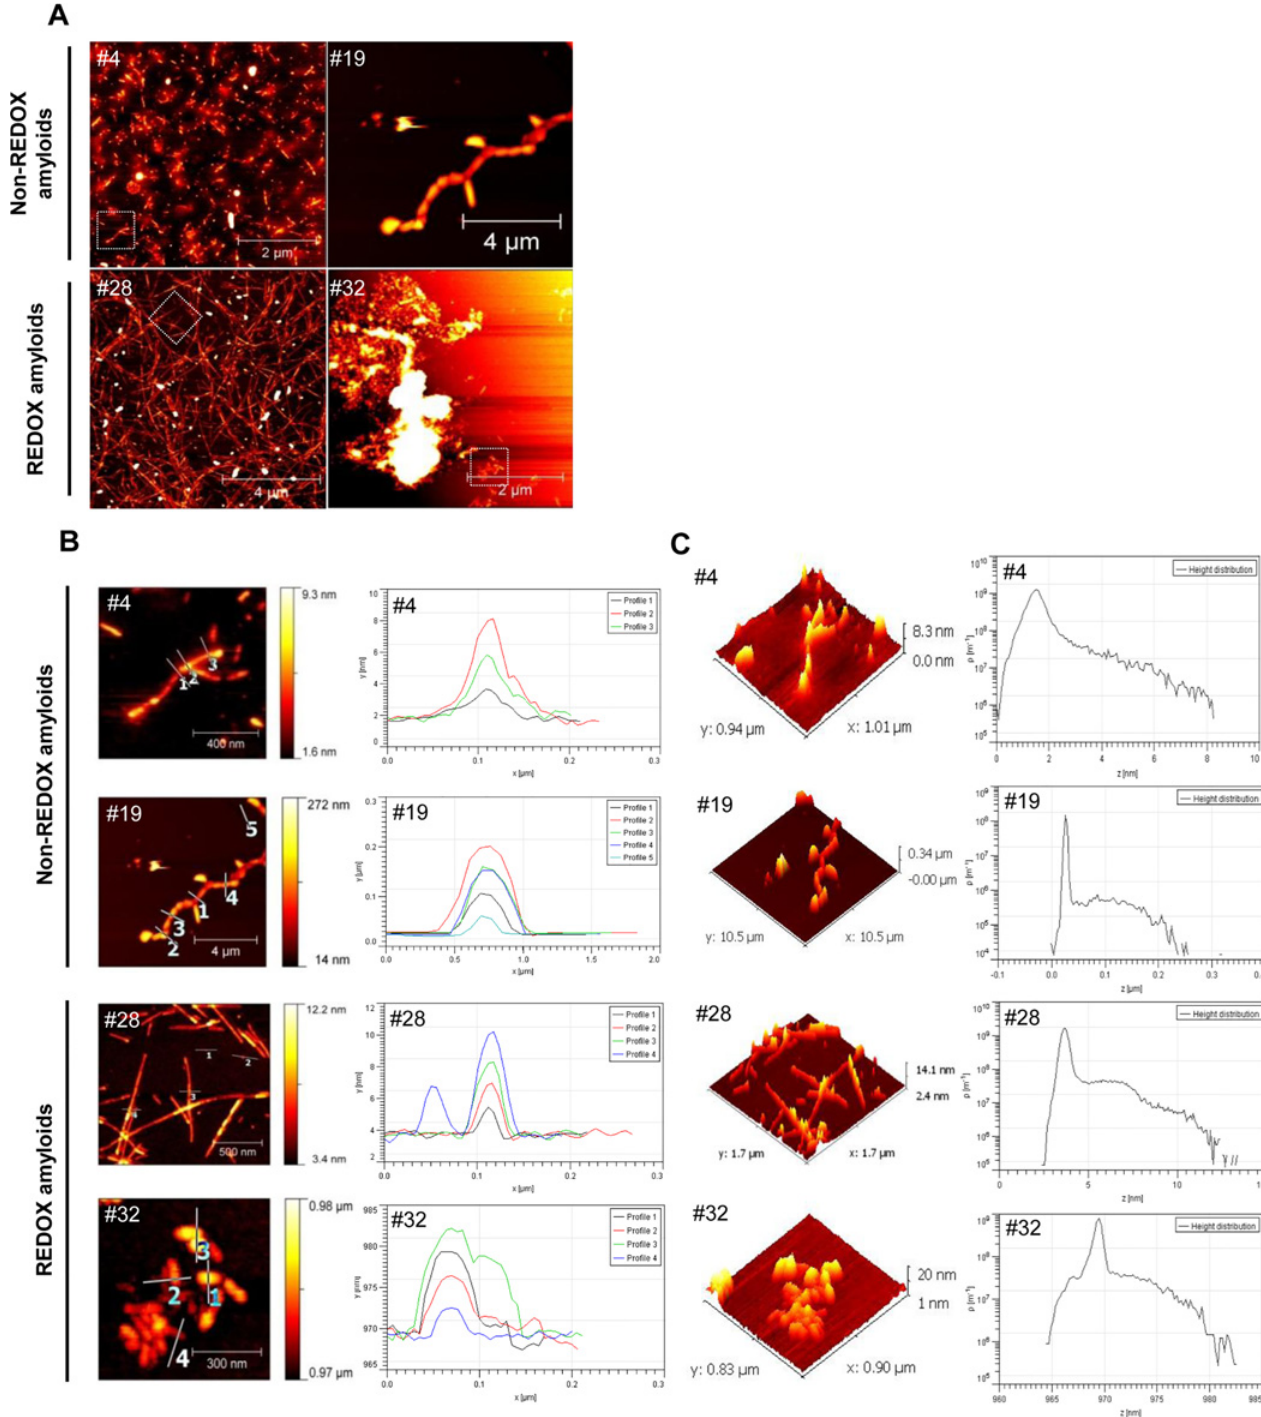
Fig 2. AFM characterization of amyloid fibrils. Atomic Force Microscopy (AFM) imaging analysis was performed at the end of the fibrillization reactions after 72 hours (amyloids #4, #19, #28, #32). AFM scan topographical images of prion protein (PrP) deposited on mica surface, large-scale images ( A ). AFM height profiles along the numbered lines in topographical images. The profile reflects the lines as numbered in the images. Higher resolution scan images belonging to the area are marked by a white dashed square in part A ( B ). Three-dimensional representation of AFM topography images and height distribution data obtained from the AFM images in part B ( C